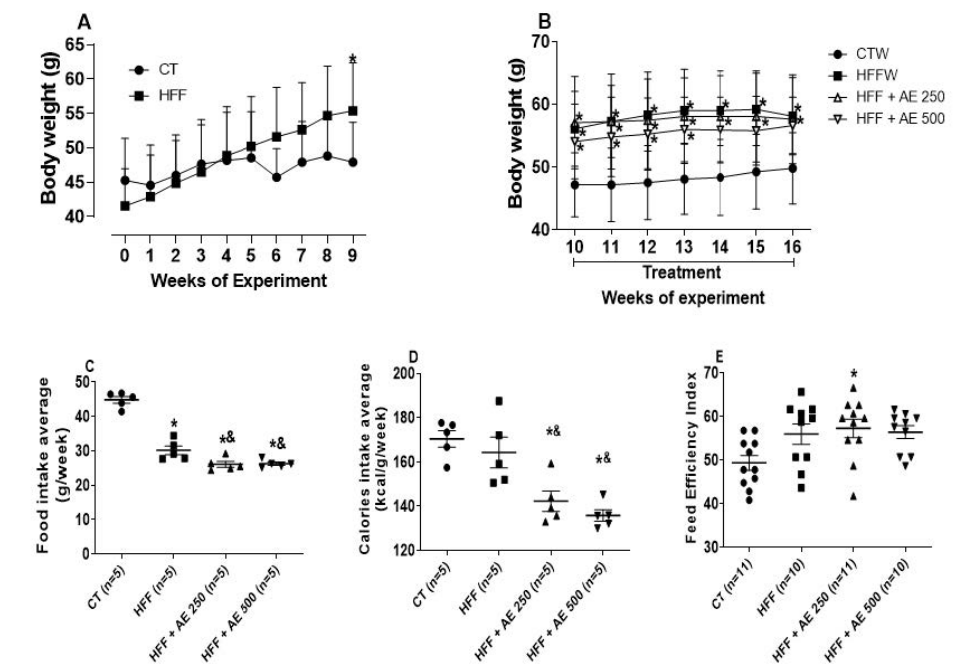
Figure 3. Effects of the high-fat/high-fructose diet and AE on body weight. ( A ) The body weight of animals fed on the regular chow diet (CT, n = 11) and on the high-fat/high-fructose diet (HFF, n = 31) for nine consecutive weeks (0: initial weight); ( B ) the body weight of animals of the full black circle: CTW diet (regular chow diet + drinking water, n = 11); full black quadrilateral: HFFW diet (high-fat / high-fructose diet + drinking water, n = 10); black up-pointing triangle: HFF + AE 250 diet (HFF + M. citrifolia fruit aqueous extract of 250 mg / kg of body weight, n = 11); and black down-pointing triangle: HFF + AE 500 diet (HFF + M. citrifolia fruit aqueous extract of 500 mg / kg of body weight, n = 10) for seven weeks (10th to 16th week); ( C ) the food intake average for 16 weeks; ( D ) the calorie intake average for 16 weeks; ( E ) the feed efficiency index for 16 weeks. The results are expressed as the mean ± standard error of the mean (SEM). Two-way ANOVA, followed by the Bonferroni post-test. * p ≤ 0.05 vs. CTW. & = p ≤ 0.05 vs.